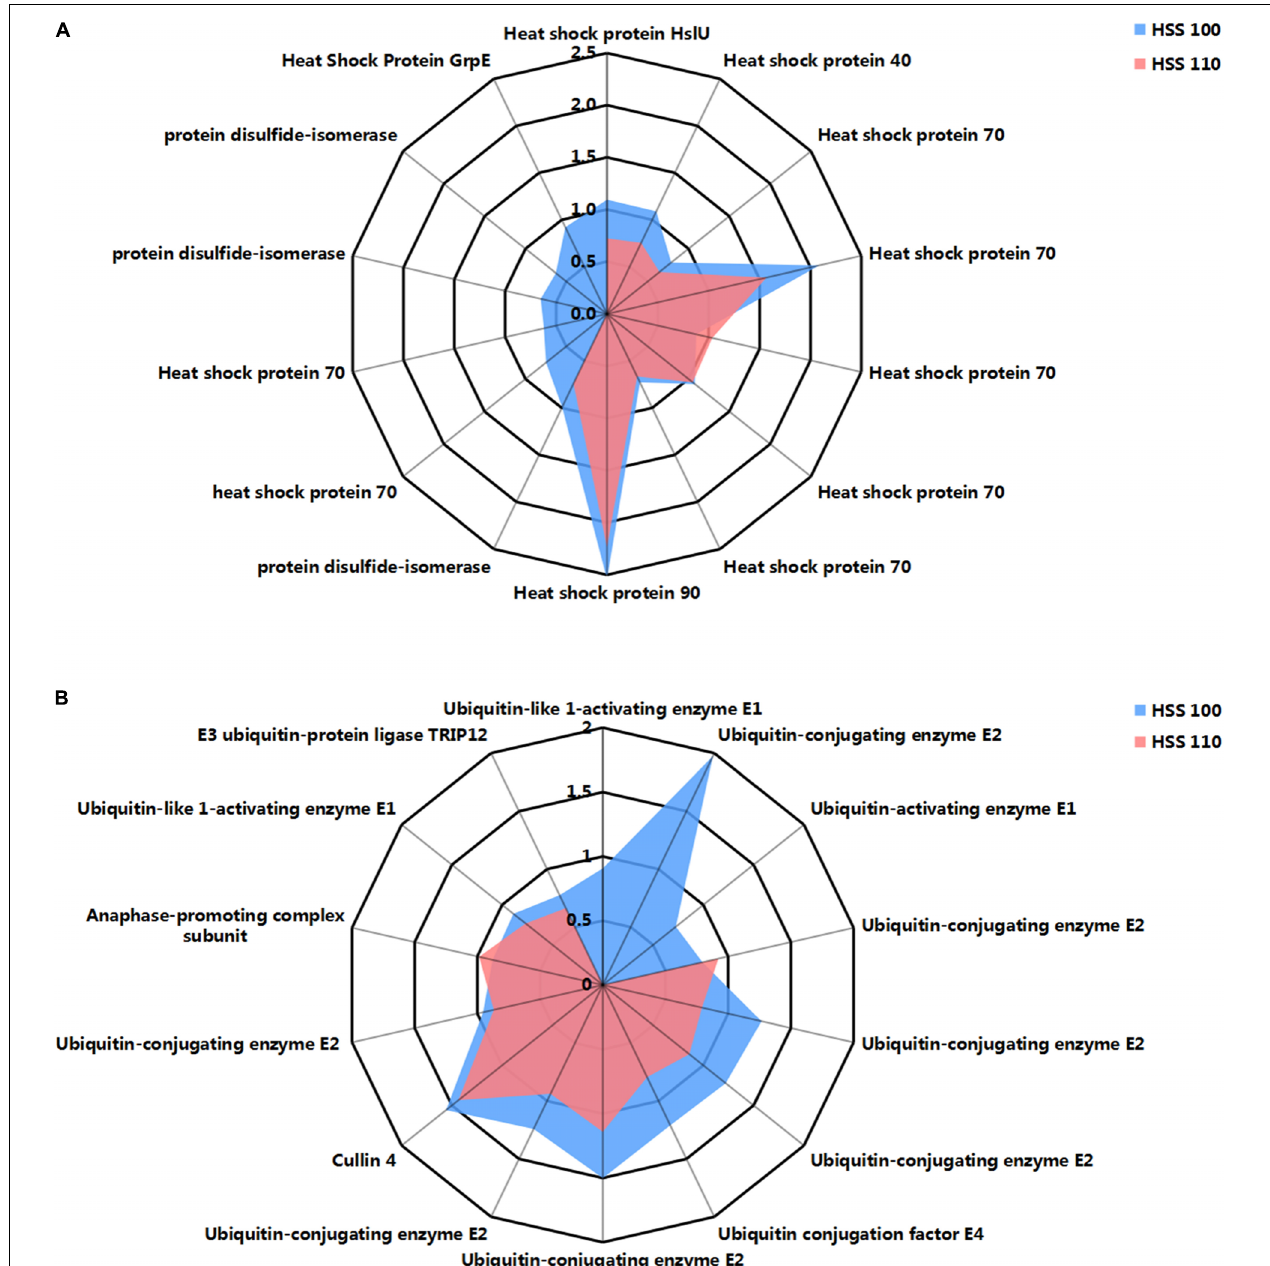
FIGURE 4 | Effects of hypersaline stress on the protein processing-related pathways of P. haitanensis . (A) Differentially abundant molecular chaperone-related proteins. (B) Differentially abundant ubiquitin-mediated proteolysis-related proteins. Radar maps were plotted based on log 2 fold change (FC) values from the proteomics dataset. Blue and red correspond to HSS 100 and 110 conditions, respectively. FC ≥ 1.5 and P <